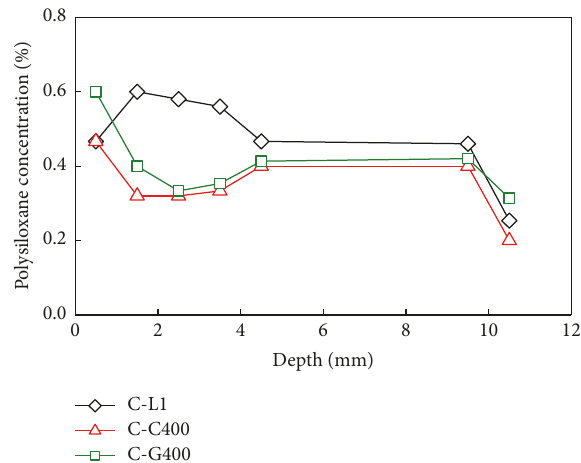
Figure 7: Polysiloxane profiles in water repellent treated concrete with silane liquid, silane cream, and silane